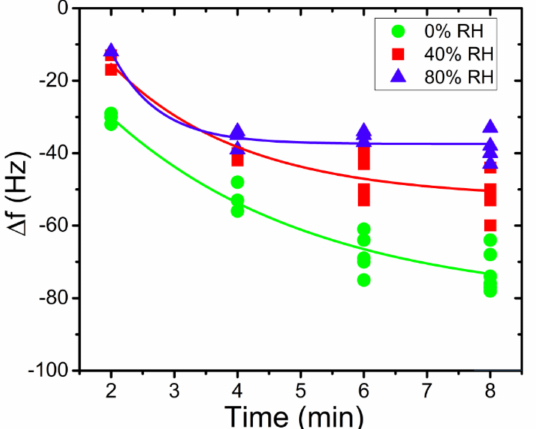
Figure 13. QCM frequency shift responses vs. sampling time at different humidity values and at fixed mercury concentration (400 µ g/m 3